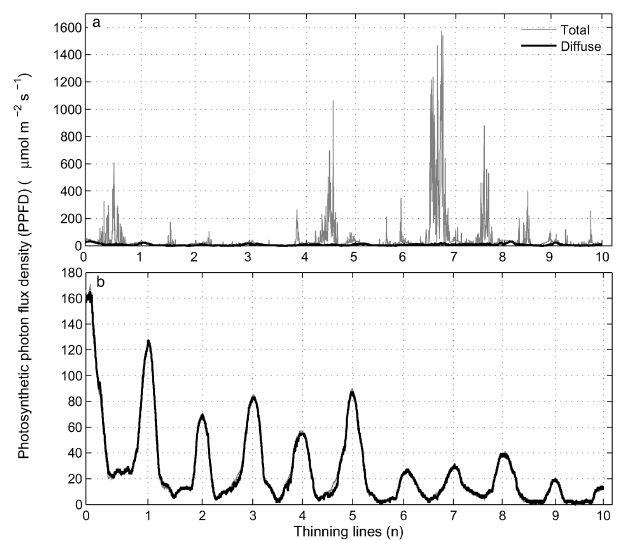
Figure 8. Photosynthetic photon flux density (PPFD) distribution below the forest canopy under clear sky (a) and under overcast (b) conditions. Total (global) PPFD is marked as a solid grey line, while diffuse PPFD measured simultaneously (using a shad- ing strip) is marked as a solid black line. Thinning lines are every